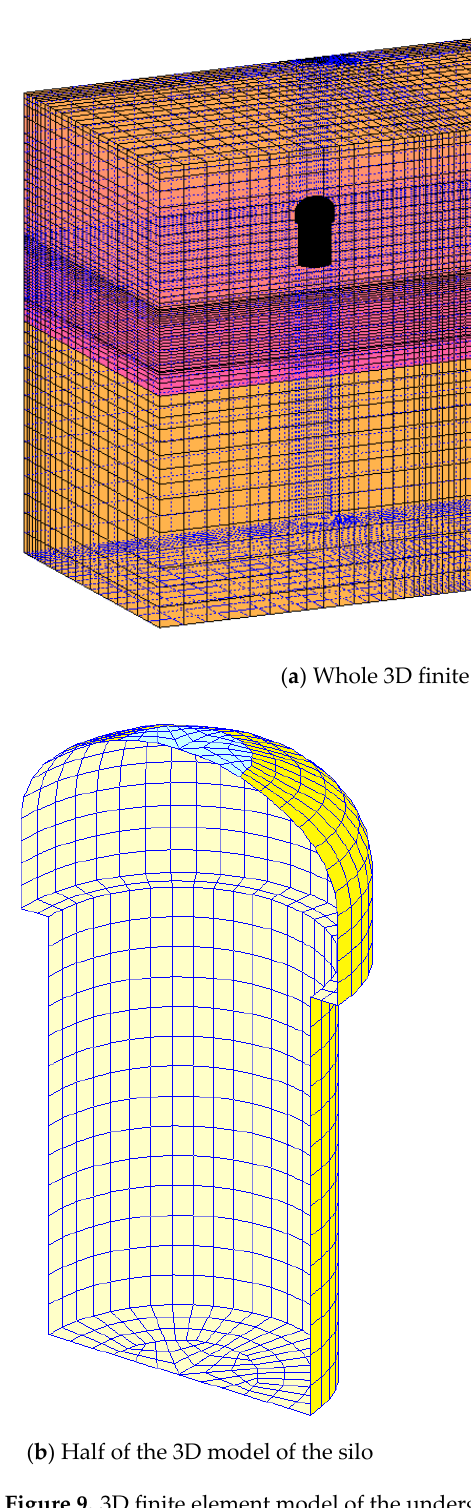
Figure 10. Key locations of the finite element model after excavation of the underground silo.